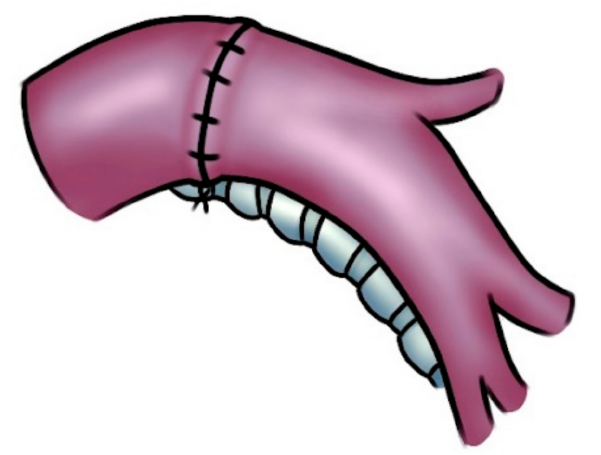
Figure 4. Left PA reconstruction with an end-to-end